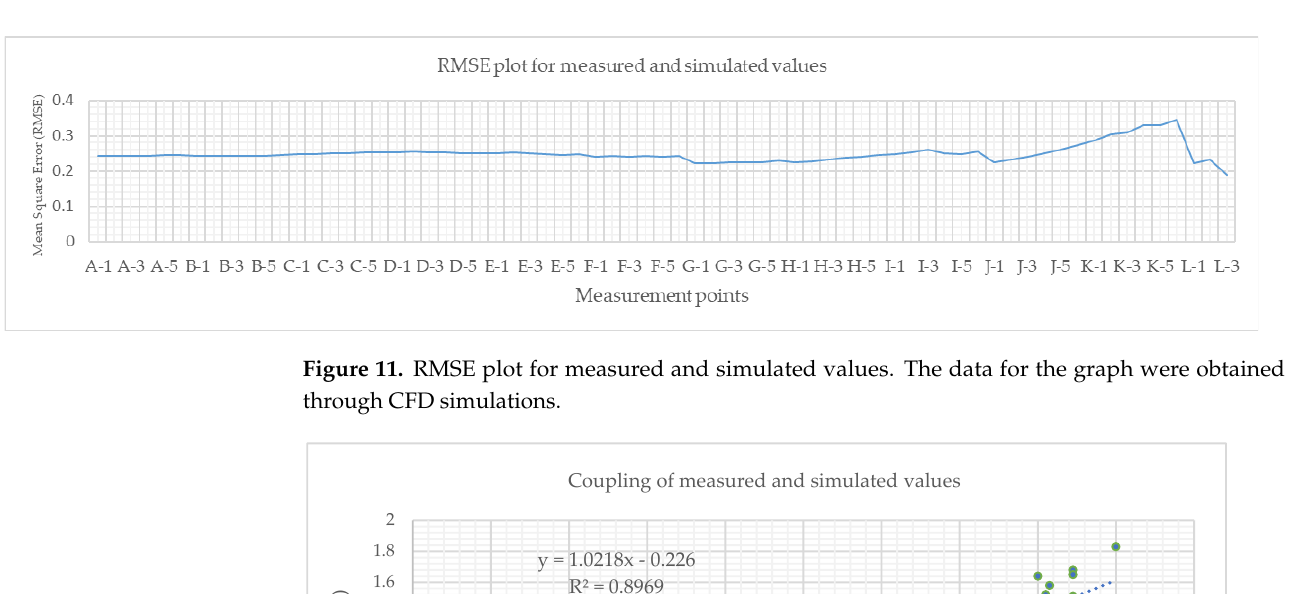
Figure 11. RMSE plot for measured and simulated values. The data for the graph were obtained through CFD simulations.